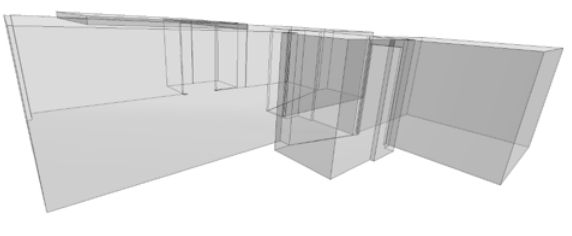
Figure 16. Visualization of IndoorGML Document